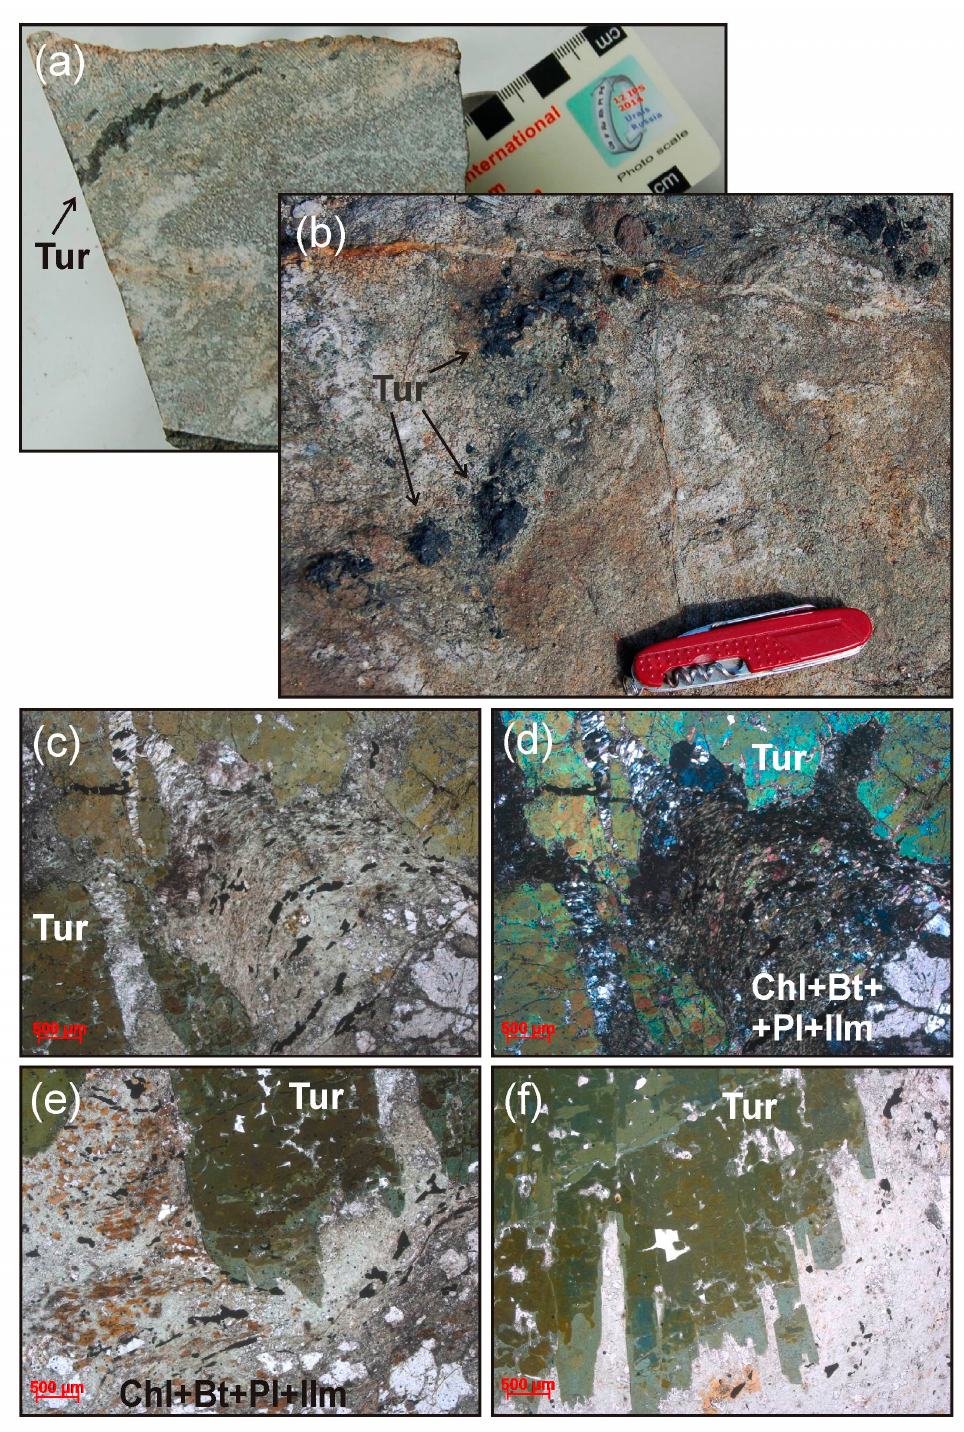
Figure 6. Tourmaline grains in diorite-gneiss: view in a piece of rock ( a ), view in the outcrop ( b ), photo of thin sections in plane polarized light ( c,e,f ), and photo of a thin section in crossed polarizes light ( d ). Tur—tourmaline, Chl—chlorite, Bt—biotite, Pl—plagioclase, Ilm—ilmenite.